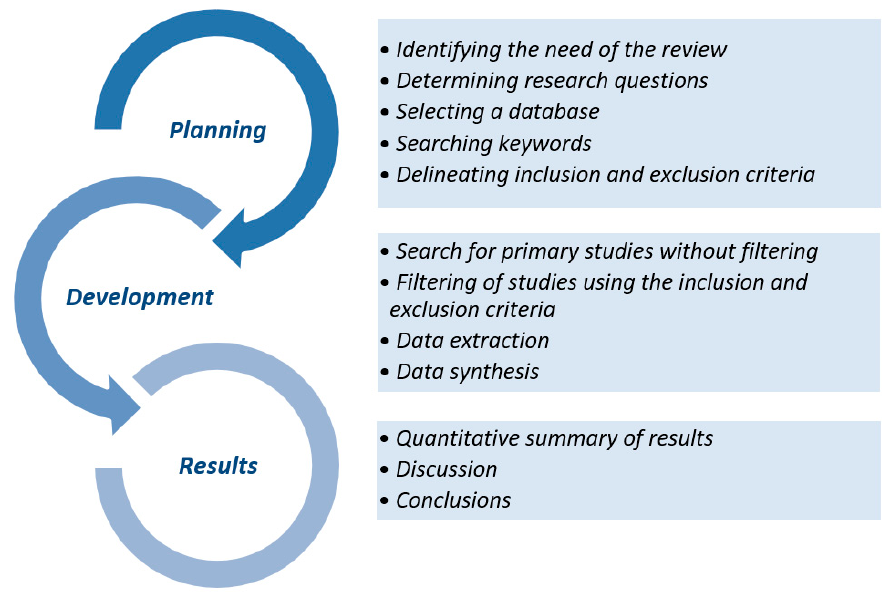
Figure 1. SR phase diagram.